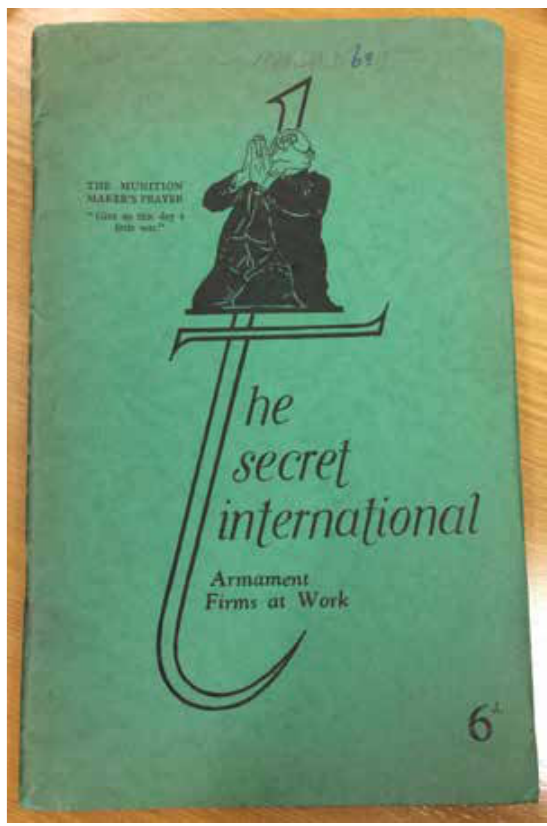
Fig 3 . Cover of The Union of Democratic Control, The Secret International: Armament Firms at Work (London, n.d.). BL,